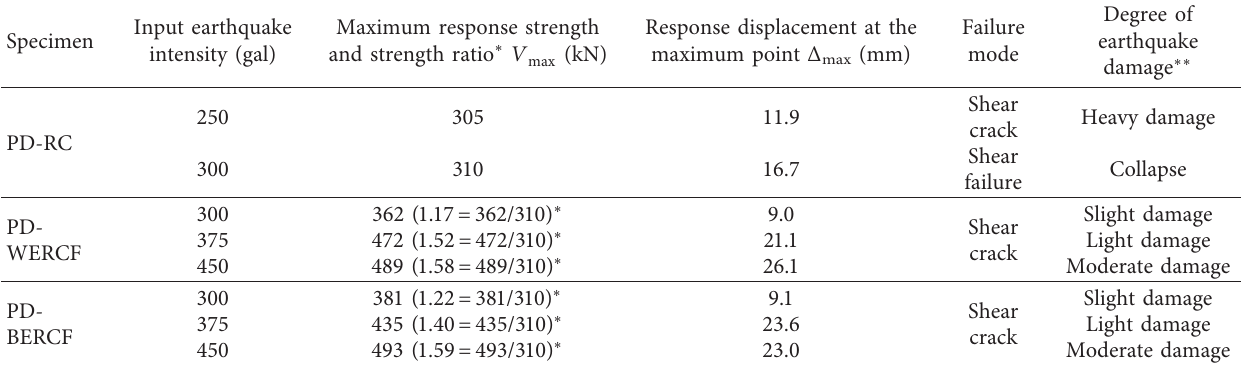
Table 6: Comparison among specimens of response strength, response displacement, and degree of earthquake damage following pseudodynamic